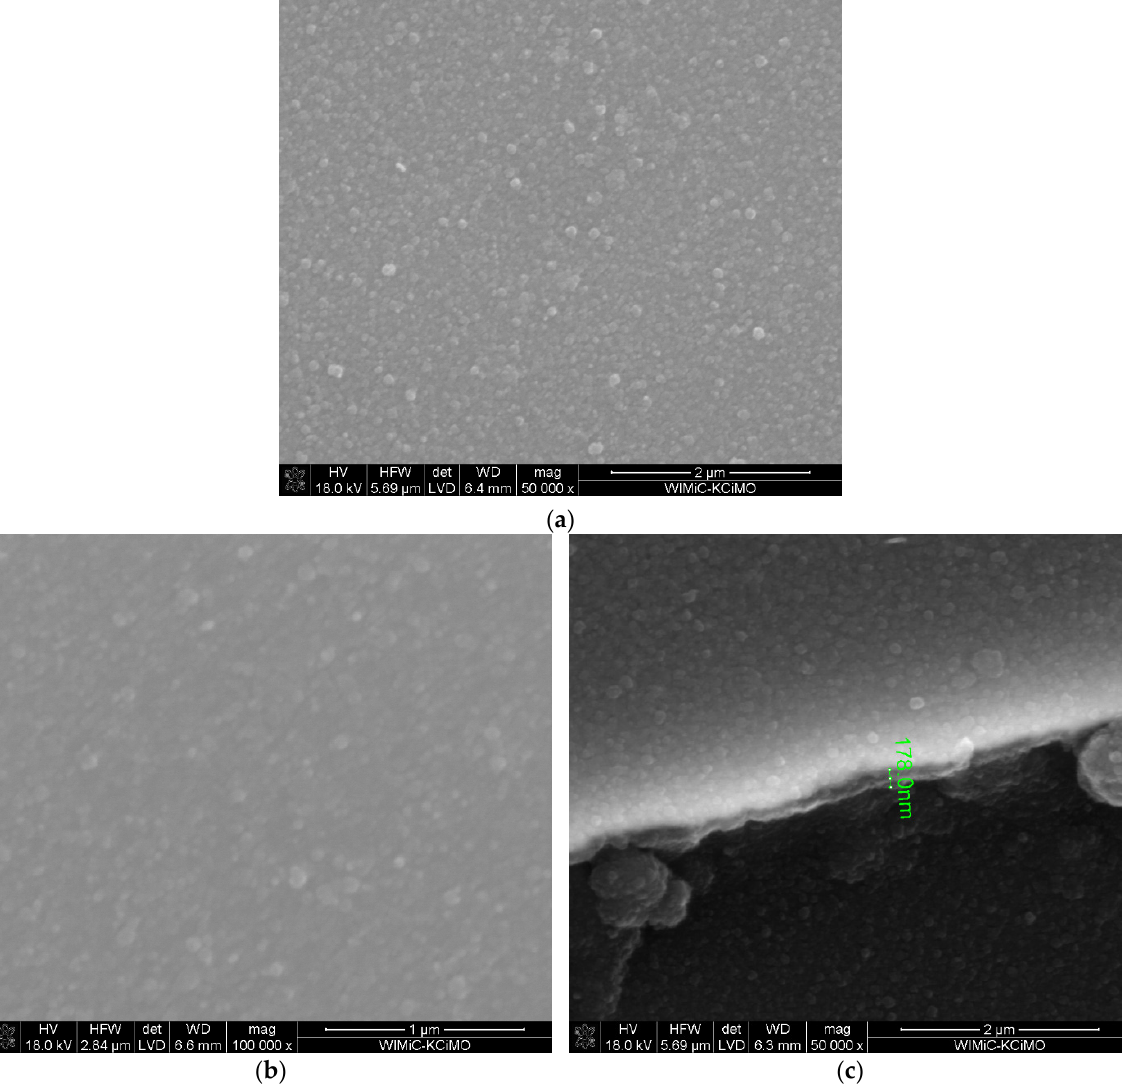
Figure 7. Microstructure of the layer deposited at temperature of 700 ◦ C on tubular substrate at dif- ferent magnifications: 50,000 × ( a ) and 100,000 × ( b ) and the cross-section: the layer–the substrate ( c ). The content of Sc(tmhd) 3 in the gas mixture: 28 mol.%. Total gas pressure: 6580 Pa. Synthesis time: 15